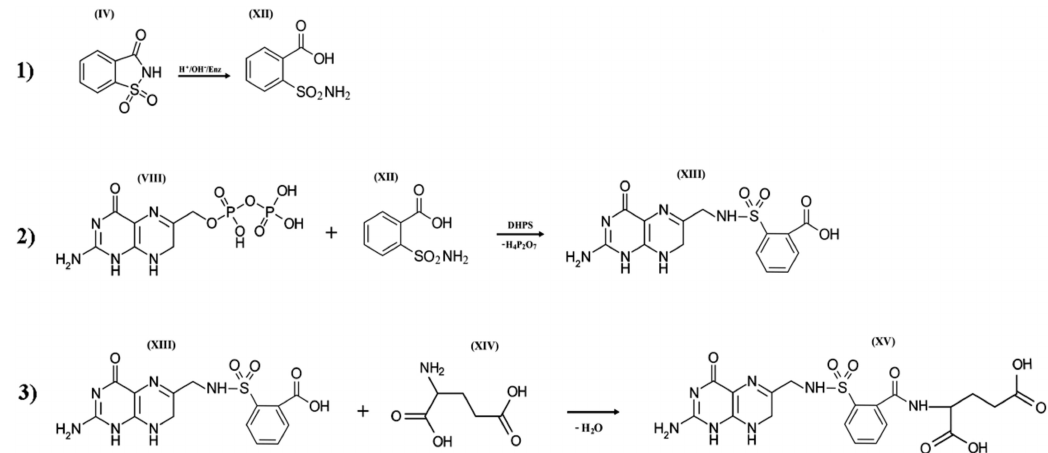
Figure 5. Three hypothetical stages of pseudofolic acid formation based on activated saccharin (IV). Stage ( 1 ), formation of o- sulphamoylbenzoic acid (XII); stage ( 2 ), interaction of 2-amino-4-hydroxy-6-pyrophosphoryl-methylpteridine (VIII) and (XII) with the formation of an intermediate (XIII); stage ( 3 ), interaction of (XIII) and L-glutamic acid (XIV) with the formation of a homologue of pseudofolic acid